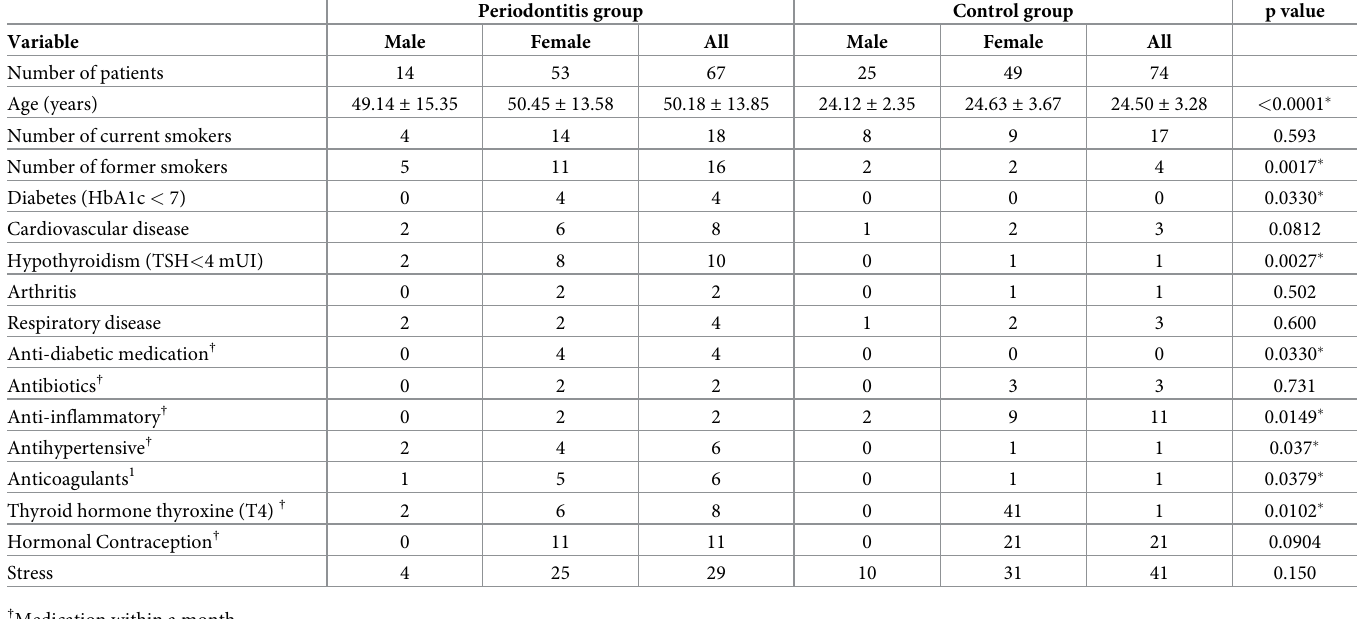
Table 1. Demographic characteristics contrasting the subjects from the periodontitis group and control group, with the p-value resulting from the between-group comparison of all subjects.